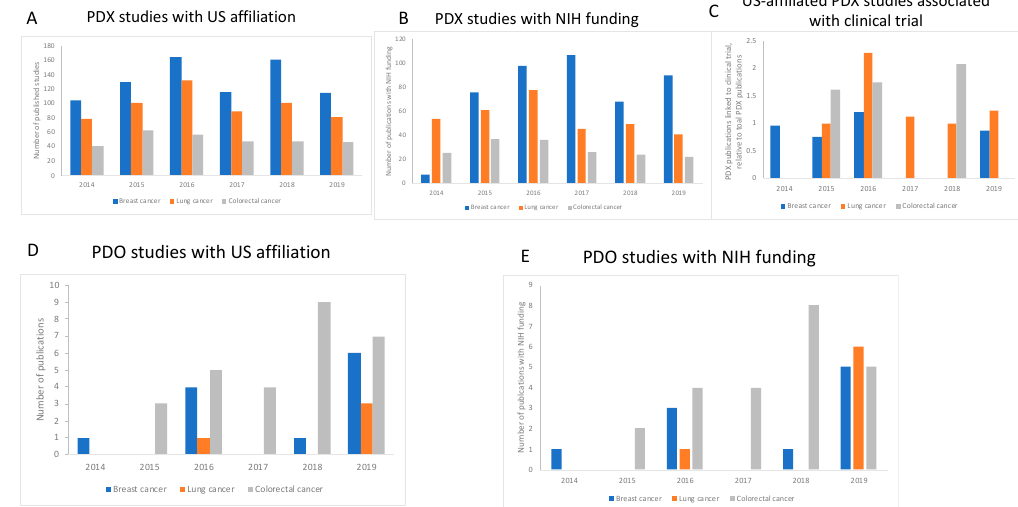
Figure 4. Research using PDX or PDO that declared an affiliation to the US. Panel A : The number of studies using PDX during the 2014-2019 period showed some fluctuations but overall remained the same during the period. Panel B shows the number of studies using PDX during the period 2014–2019 that received National Institutes of Health (NIH) funding. Note that the number of studies has not increased over the years. Panel C : The proportion of studies using PDX, relative to the total number of using PDX, which were associated with clinical trials, does not show a growing trend. Panel D indicates that research using PDO is on the increase in the US. Panel E shows the number of studies using PDO that received funds from NIH and indicates that most studies using PDO in the US are NIH-funded (or part NIH-funded).